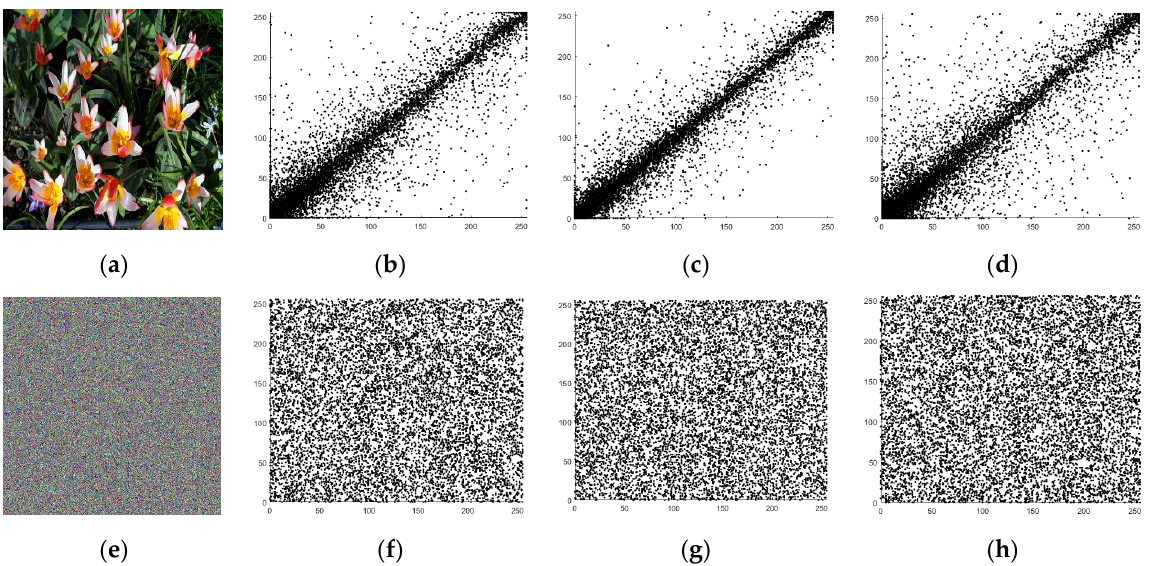
Figure 5. ( a ) Plain Tulips image; ( b – d ) correlation diagram of plain Tulip image in horizontal, diagonal, and vertical axes, correspondingly; ( e ) encrypted Tulips image; ( f – h ) correlation diagram of encrypted Tulip image in horizontal, diagonal, and vertical axes, correspondingly.